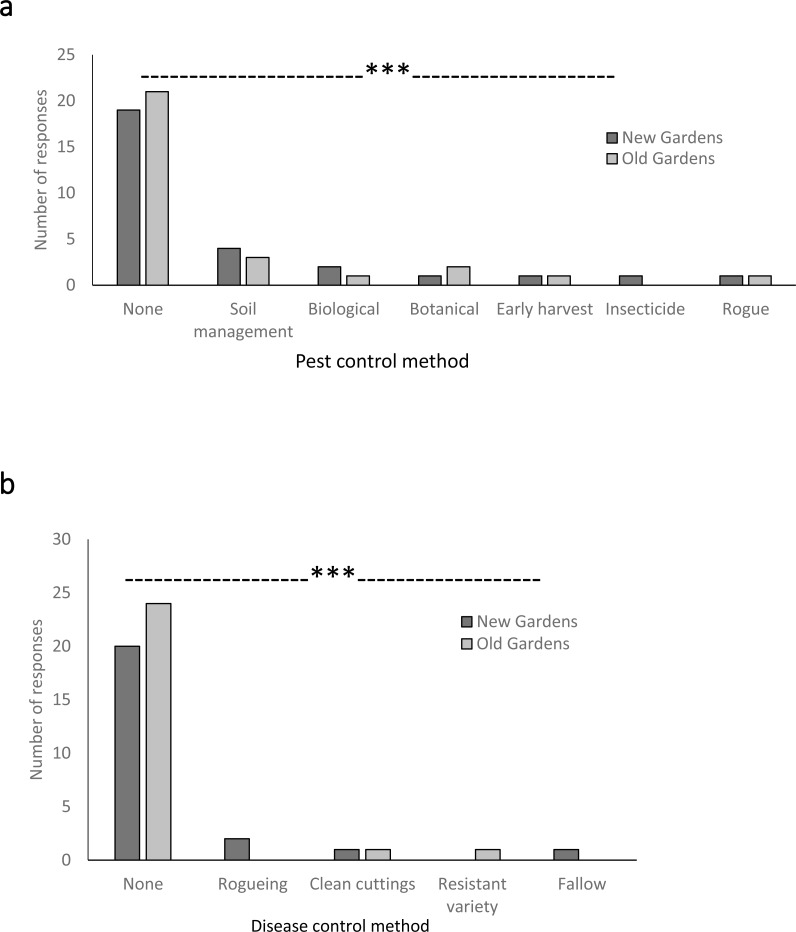
Reported actions taken to control pests (A) and diseases (B) on sweetpotato crops.(Chi-square test compared management approaches within each garden age: PESTS, new gardens, X2 = 41.989, df = 6, p < 0.001; old gardens, X2 = 52.738, df = 6, p < 0.001. DISEASES, new gardens, X2 = 38.338, df = 4, p < 0.001; old gardens, X2 = 52.277, df = 4, p < 0.001).